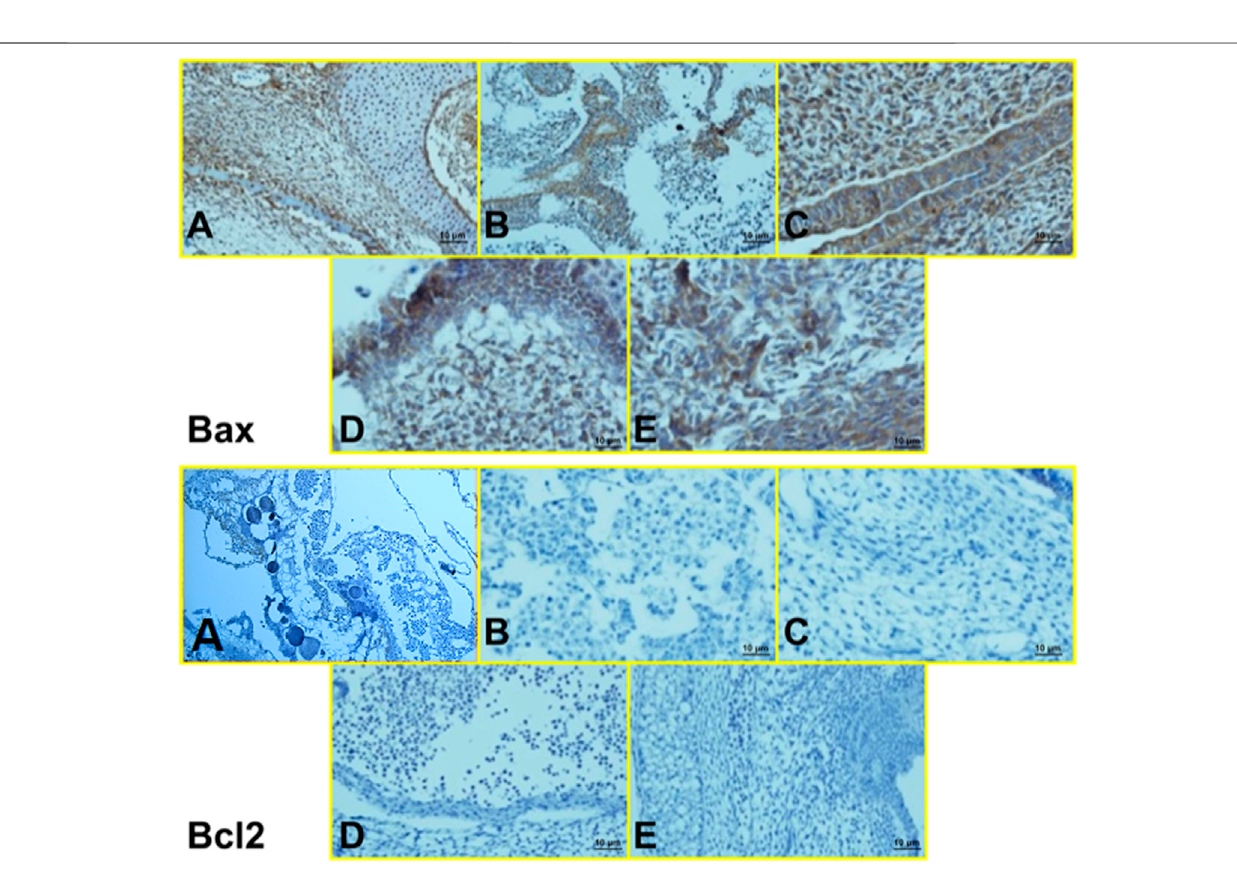
Frontiers in Pharmacology |